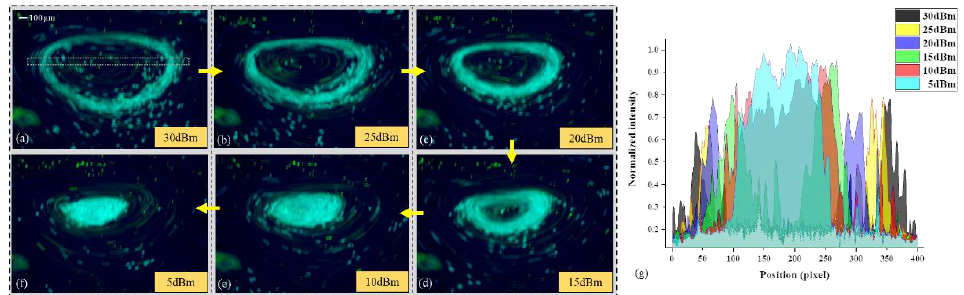
Figure 6. ( a – f ) Describes the shrinking process of particle ring with different input powers. The normalized pixel intensity (NPI) values measured from the center of the vortex (see the dashed rectangles in ( a ), from left to right) are plotted in ( g ) to characterize the concentration of particles at different signal intensities.